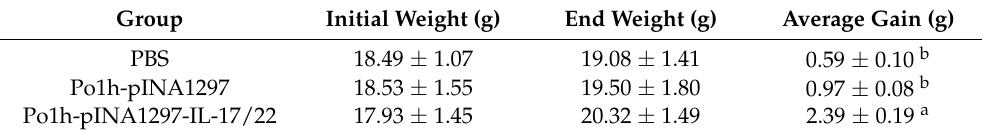
Table 1. Changes in mouse weights during 5 weeks of observation ( n = 10/group).